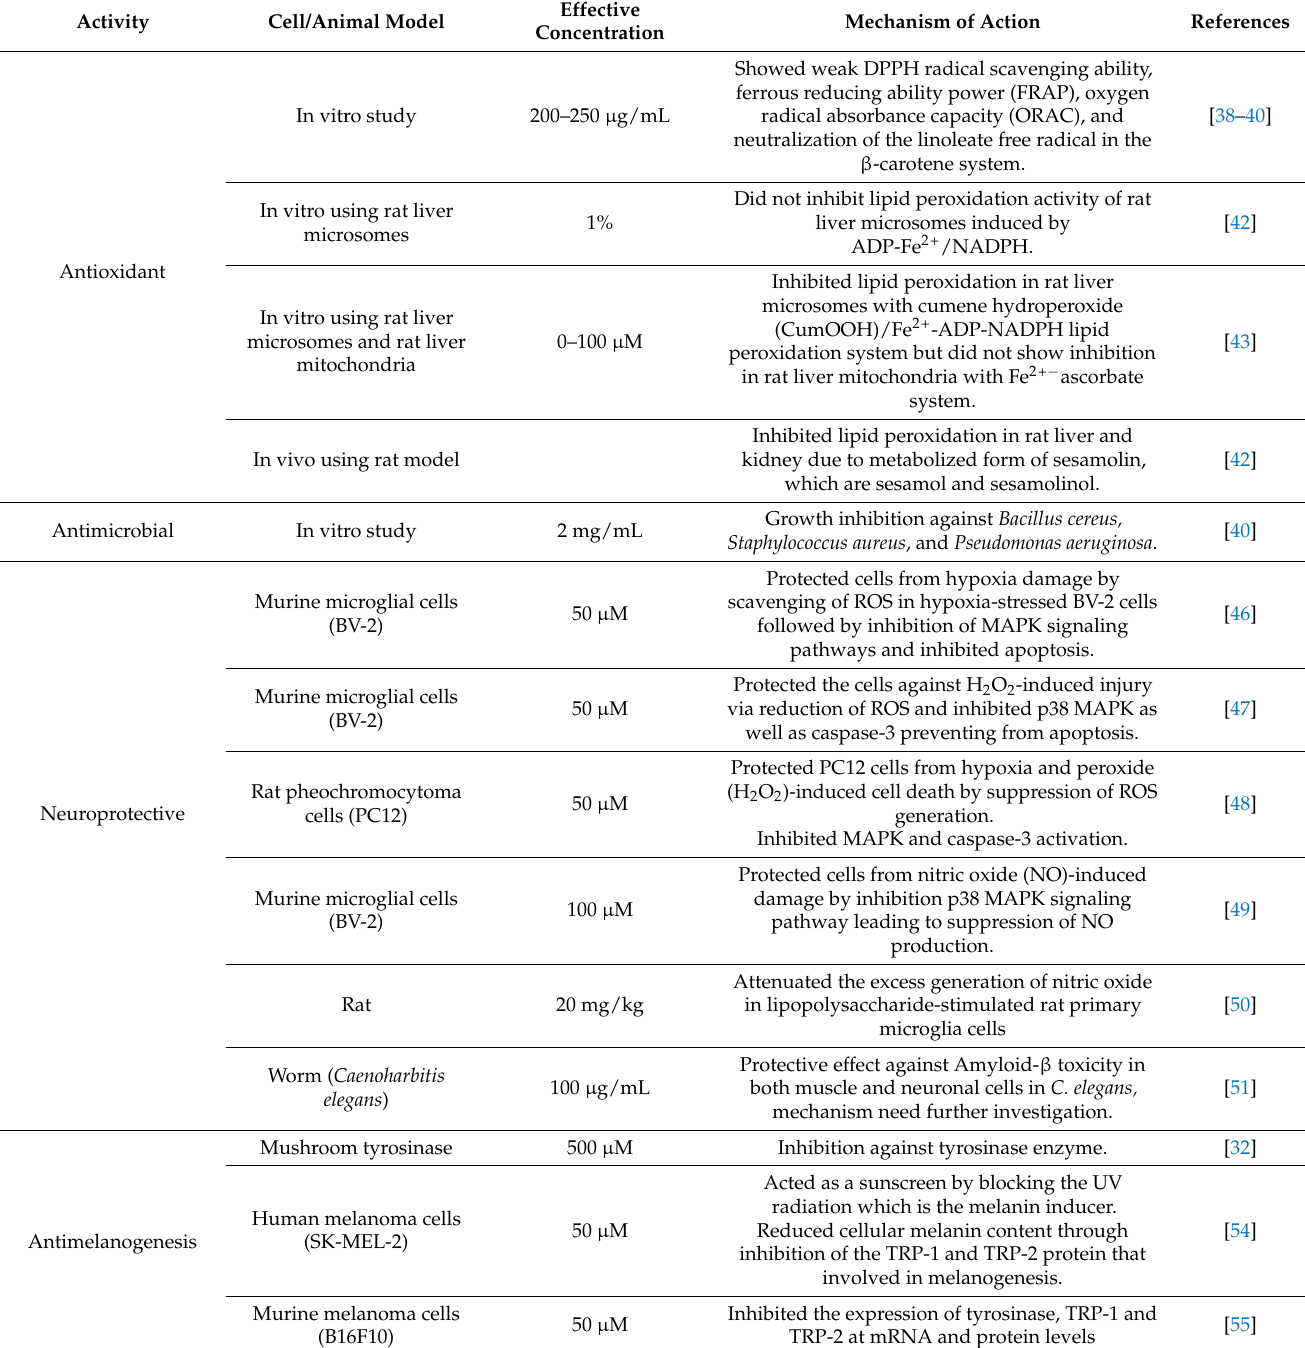
Table 3. Pharmacological activities of